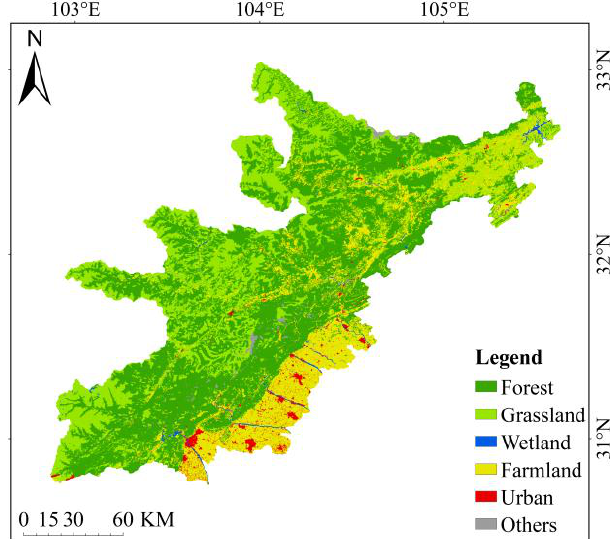
Figure 3. Map of ecosystem composition in 2018.